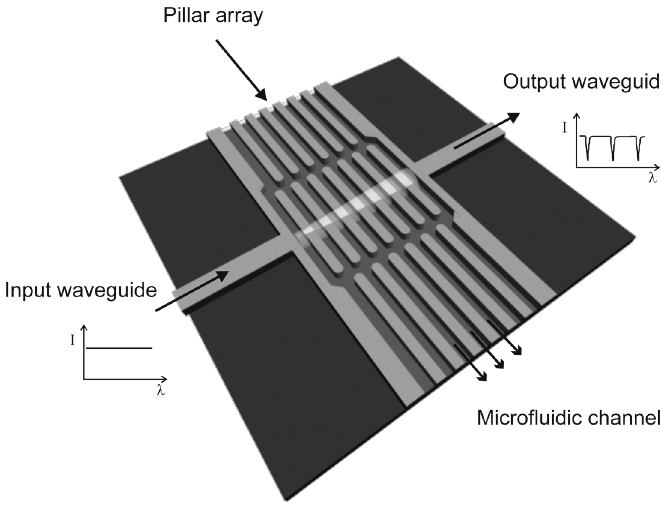
Figure 1 . Schematic view of an on-column 1D photonic crystal refractive index chemical sensor. The detection region consists of a pillar array and integrated waveguides coupling infrared light through the